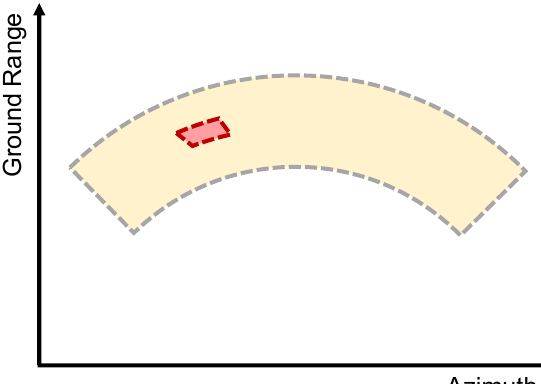
Figure 14. The pulse and Doppler extent of an ideal point target projected onto the ground (yellow). Two-dimensional DBF is capable of separating the extent to small patches (red box) in the range-compressed Doppler domain. This reduces the blindspot of the INC estimation.